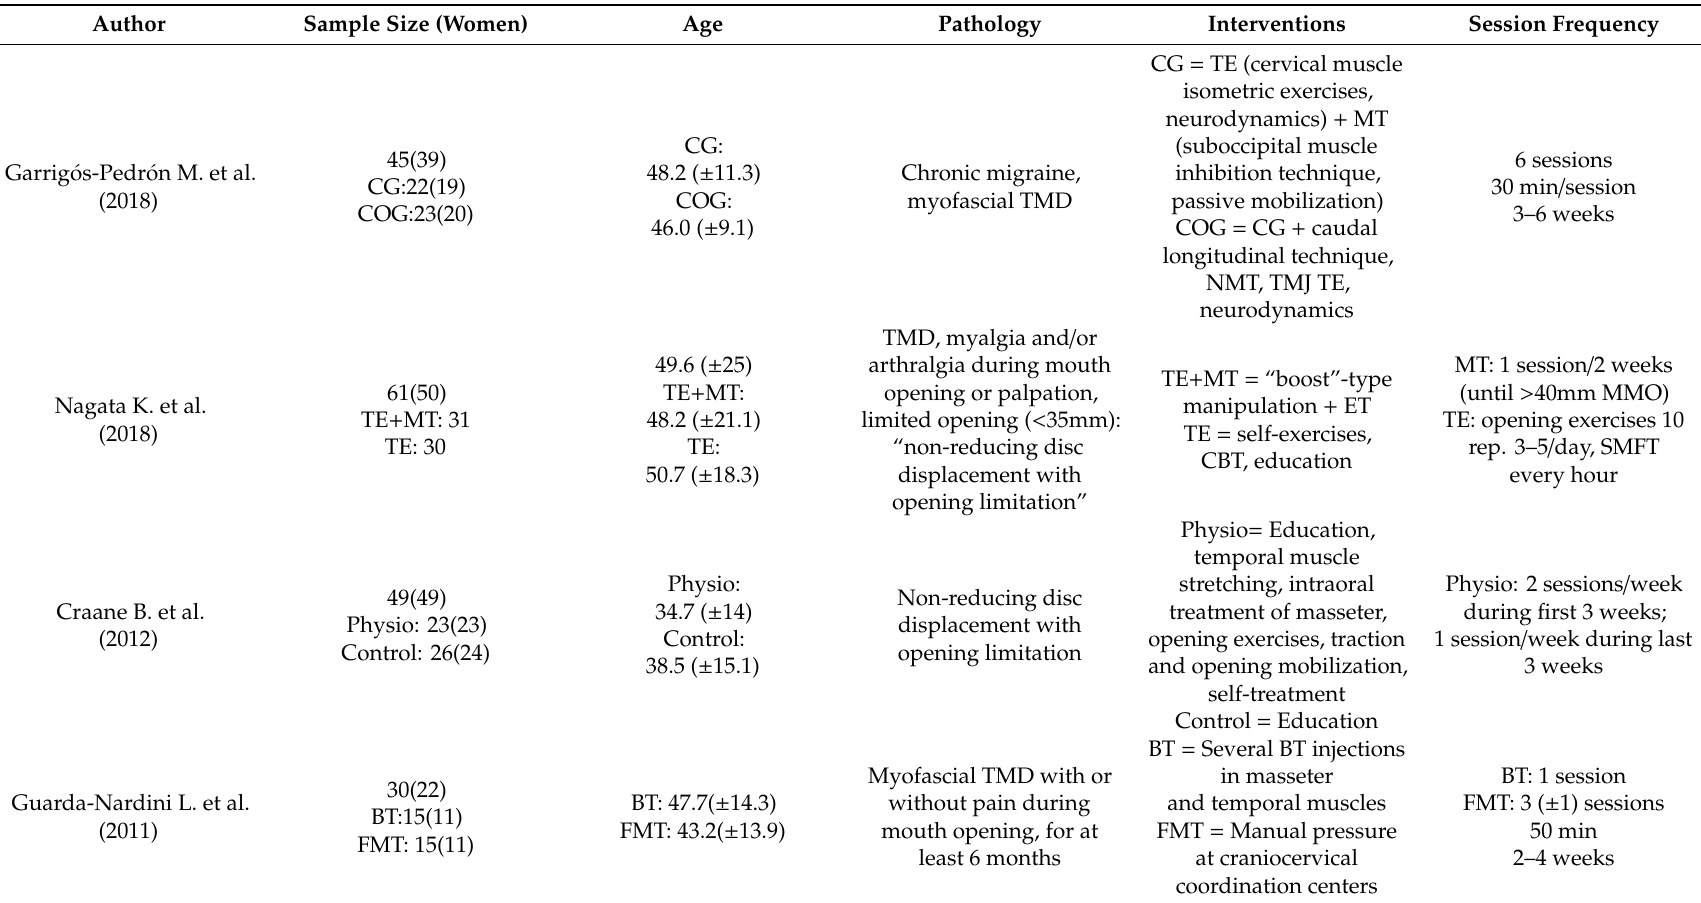
Table 2. Included studies’